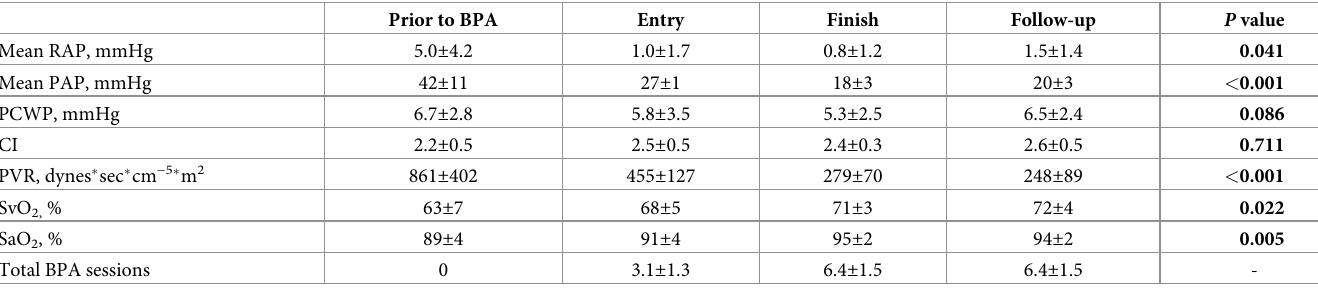
Table 3. Trend of parameters of right heart